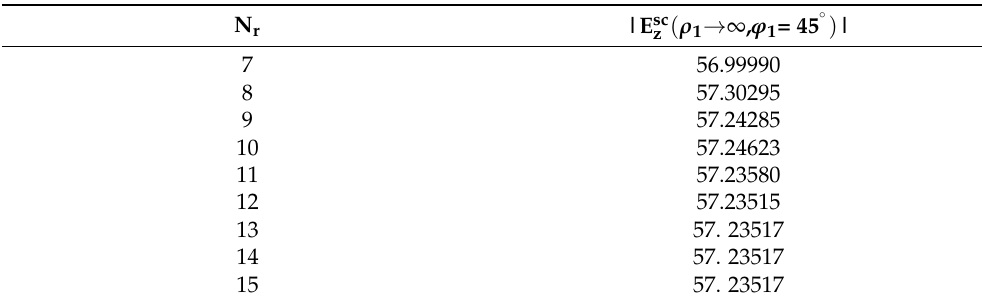
(cid:12) Table 1. (cid:12) E sc z ( ρ 1 → ∞ , ϕ 1 = 45 the inset of Figure 5.